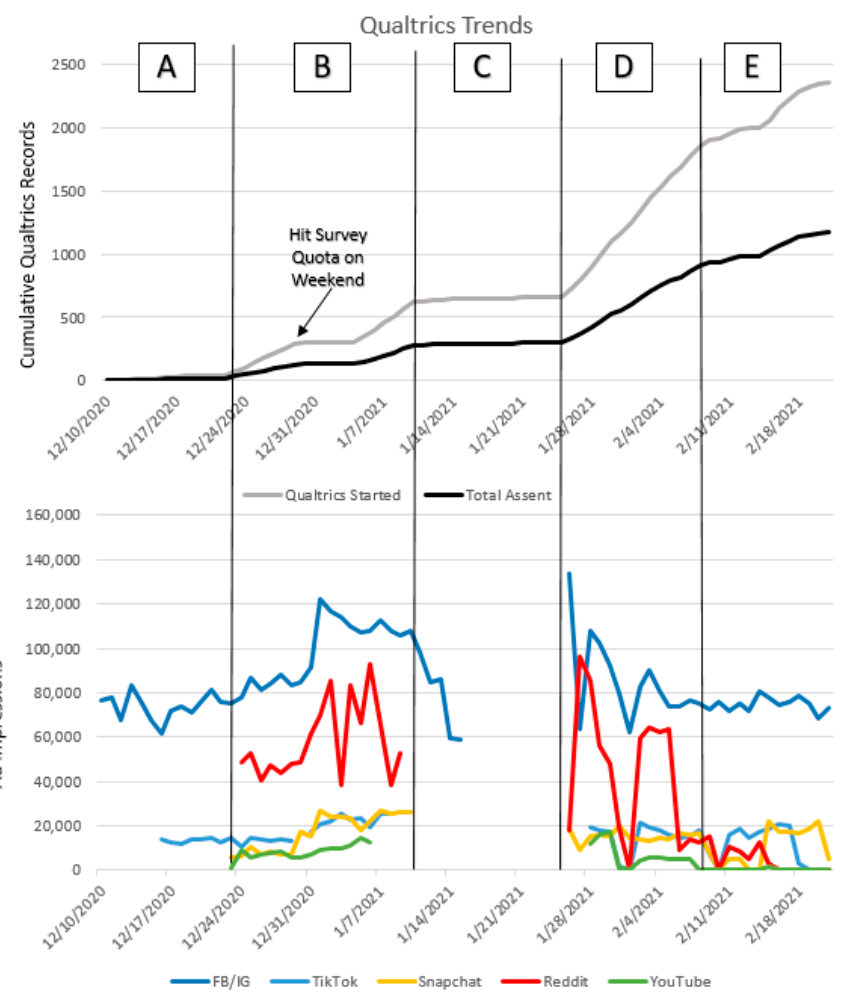
Figure 3. Cumulative Qualtrics records created compared to recruitment platforms used to recruit the Testing Group. ( A ) Facebook/Instagram (FB/IG) only, added in TikTok, ( B ) three additional platforms added, ( C ) paused additional platforms (reversal design), ( D ) all platforms with ads shuffled and more money allocated to Snapchat and Reddit, ( E ) reduced to standard daily budget.